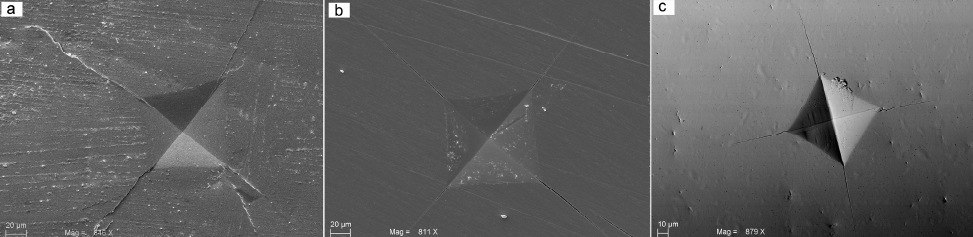
Figure 4. SEM images of the Vickers indentations during the microhardness test. The dimension of the indentation determined the hardness, while the course and the length of the generated microcracks at the angles of the indentations were used to evaluate the fracture toughness. ( a ) High-translucent zirconia; ( b ) low-translucent zirconia; ( c ) high-translucent zirconia after aging.